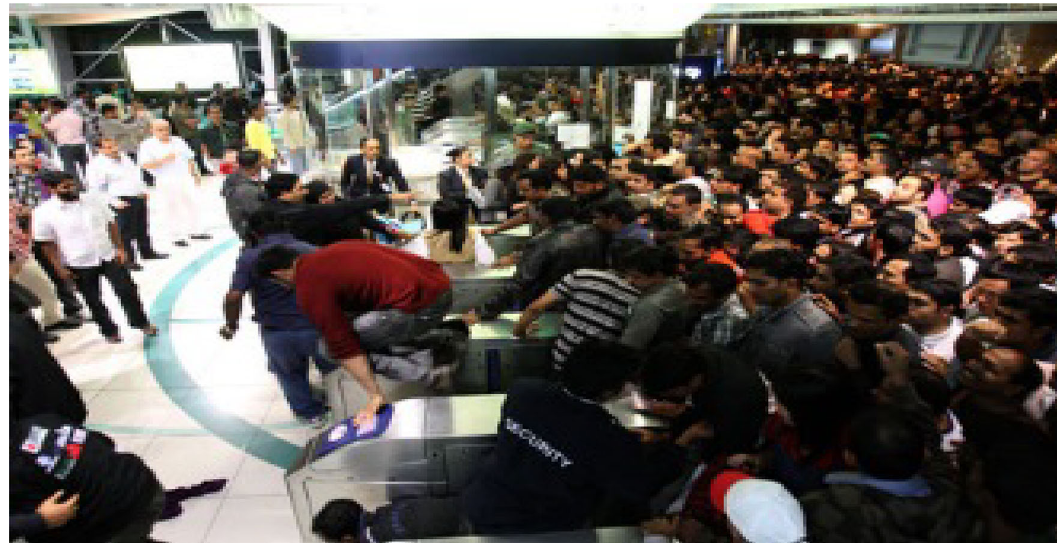
Fig. 9 Illustrative example of service disruption. Adapted from Kasmi